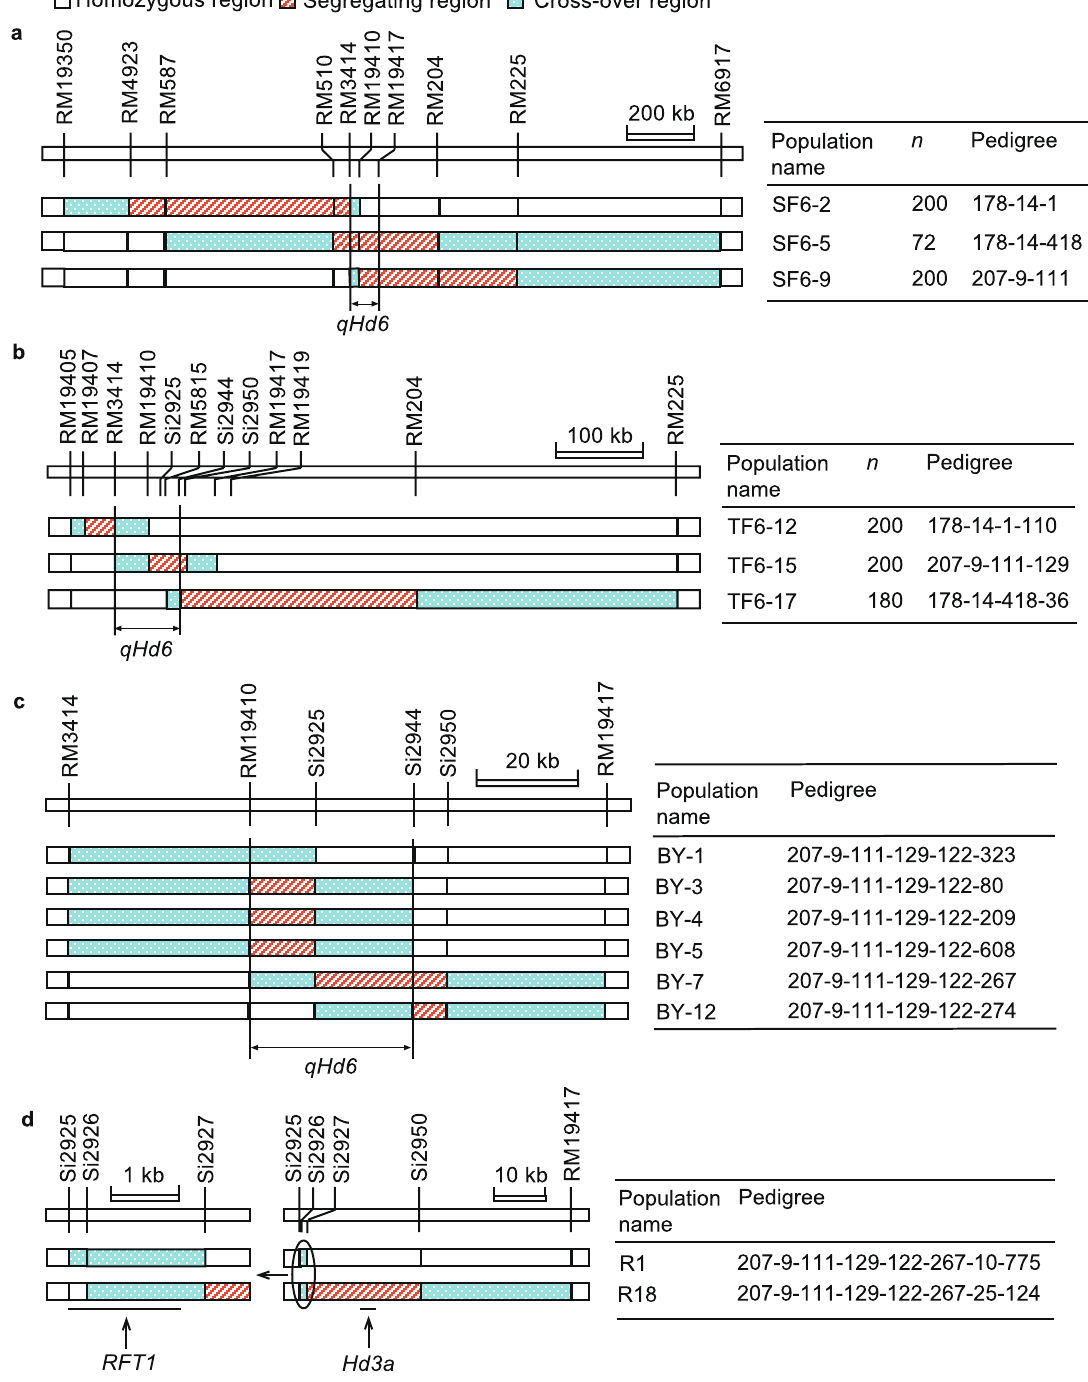
Figure 3. Segregating regions of four sets of NIL-F 2 populations. ( a ) Three populations in F 11 used to validate the location and effect of qHd6 disclosed in the previous generation. ( b ) Three populations in F 12 used to delimitate qHd6 into a 62.1-kb region. ( c ) Six populations in F 14 used to delimitate qHd6 into a 29.9-kb region. ( d ) Two populations in F 16 used to place qHd6 at the RFT1 locus and to construct NILs for analyzing the RFT1 pleiotropism. Pedigree refers to the pedigree of the residual heterozygote that was selfed to produce the NIL-F 2 population, in which the first number is the Plant No in F 8 , followed by those in later generations up to F 10 , F 11 , F 13 and F 15 in ( a,b,c and d ), respectively. n , number of